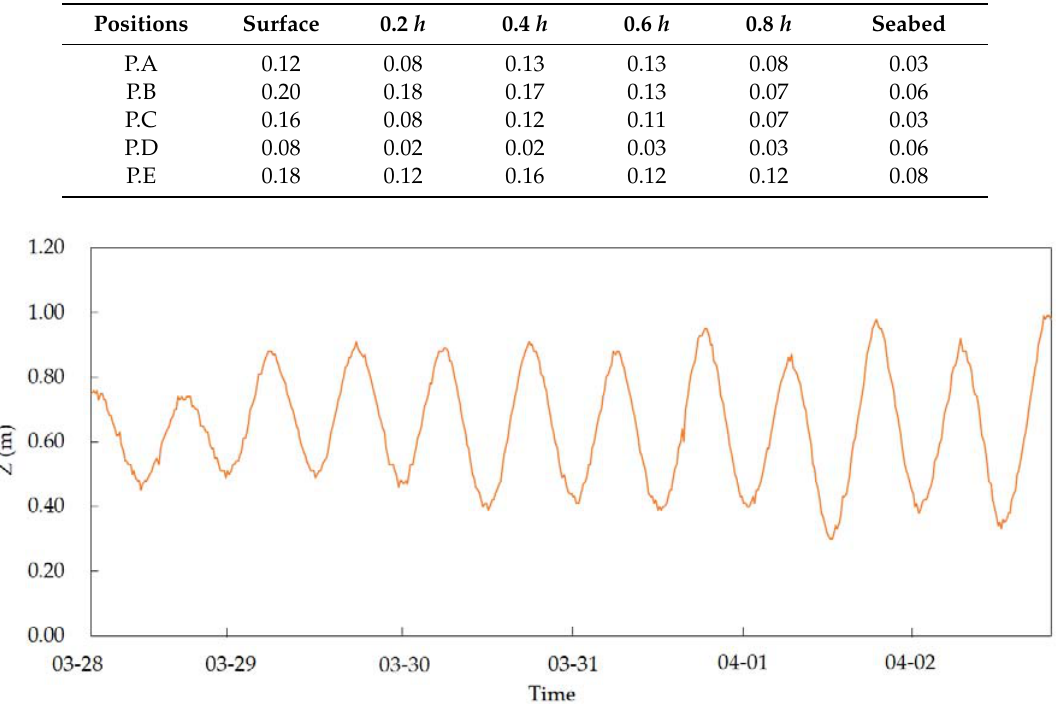
Figure 4. Tidal ‐ level observations. Figure 4. Tidal-level